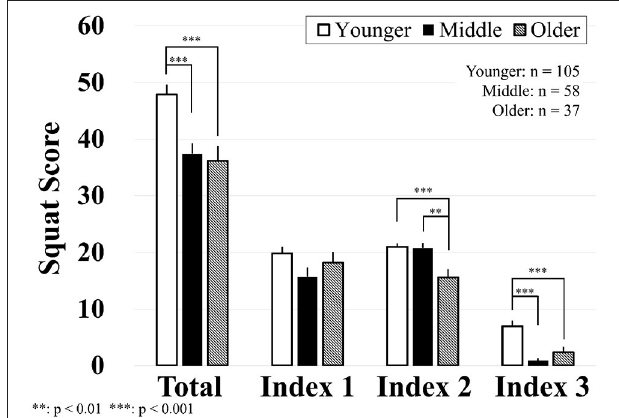
FIGURE 6 | Results of squat scores. Data are mean value and standard error.